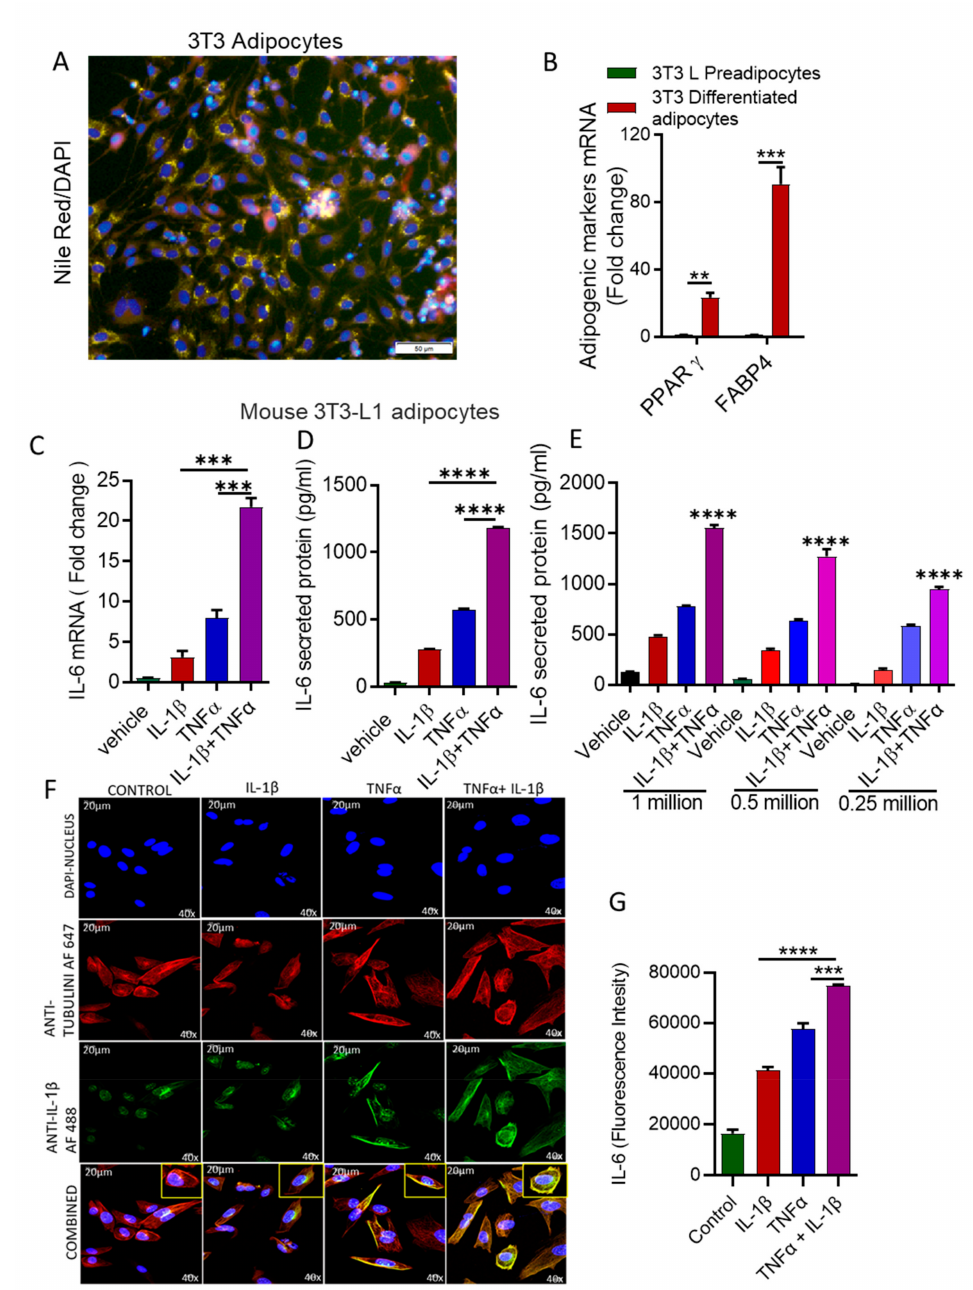
Figure 1. Combined effect of IL-1 β and TNF α on IL-6 expression in mouse adipocytes. ( A , B ) 3T3 L preadipocytes were differentiated into adipocytes as described in materials & methods. Lipid droplets in adipocytes were determined by using Nile Red staining. Morphology of adipocytes and adipogenic markers were shown. Scale Bar 50 µ m. Mouse 3T3-L adipocytes were stimulated with IL-1 β (10 ng/mL) and TNF α (10 ng/mL) alone or in combination for 24 h. Cells and culture media were collected. ( C ) Total RNA was extracted from the cells and IL-6 mRNA was quantified by real time PCR. Relative mRNA expression was expressed as a fold change. ( D ) Secreted IL-6 protein in culture media was determined by ELISA. ( E ) Different number of cells (1, 0.5, 0.25 million) were treated with IL-1 β (10 ng/mL) and TNF α (10 ng/mL) alone or in combination for 24 h. Cells and culture media were collected, Secreted IL-6 protein in culture media was determined by ELISA. ( F ) 3T3 adipocyte cells were stained for confocal microscopy, as described in the Materials and Methods section. IL-6 expression is shown by green fluorescence (inset), whereas nuclei are stained blue with DAPI (original magnification × 40). Scale Bar 20 µ m. ( G ) IL-6 fluorescence intensity was determined for 10 random images. The results obtained from three independent experiments are shown. All data are expressed as mean ± SEM ( n = 3). ** p < 0.01, *** p < 0.001, **** p <